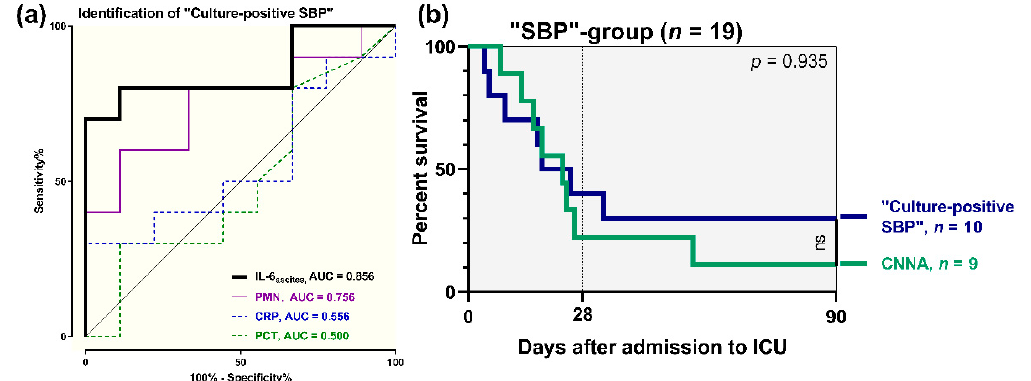
Figure 4. ( a ) Diagnostic potential of baseline ascitic interleukin 6 (IL-6 ascites ), polymorphonuclear neutrophils (PMN), CRP, and PCT to identify positive ascitic bacterial culture (“ culture-positive SBP ”); ( b ) survival analyses in 19 patients with spontaneous bacterial peritonitis (SBP): “ culture-positive SBP ” vs. “ culture-negative neutrocytic ascites ” (CNNA).